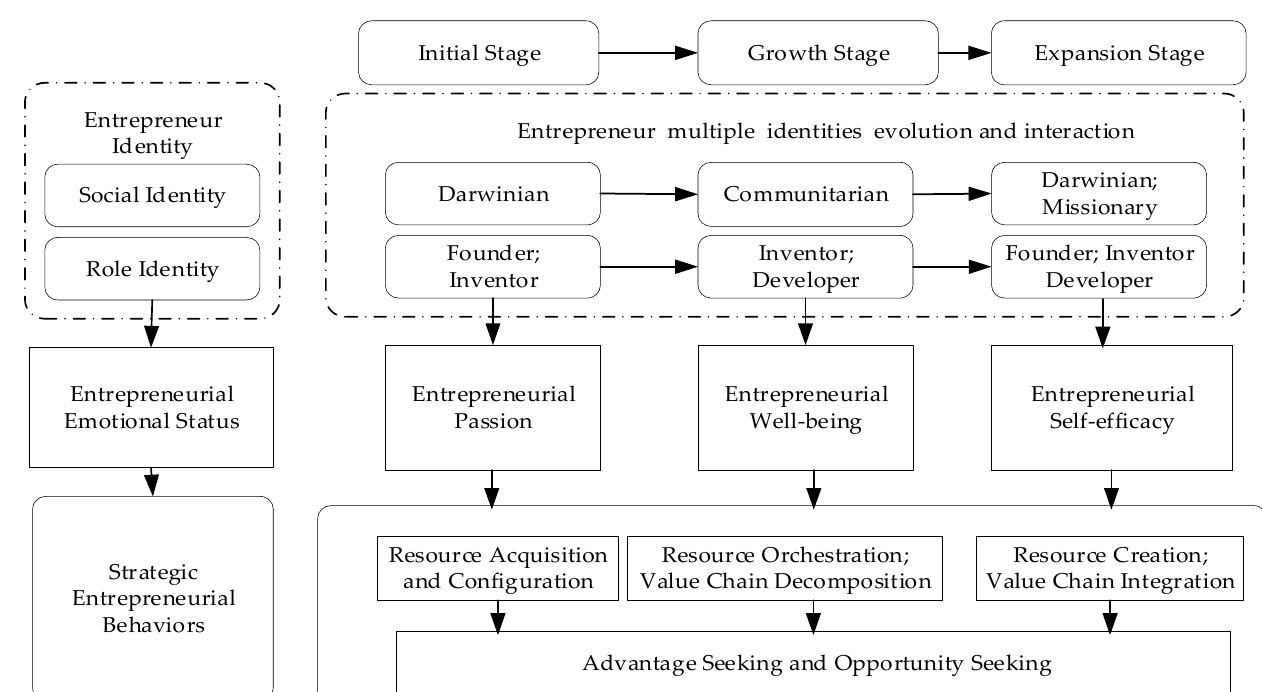
Figure 1. Theoretical Model.